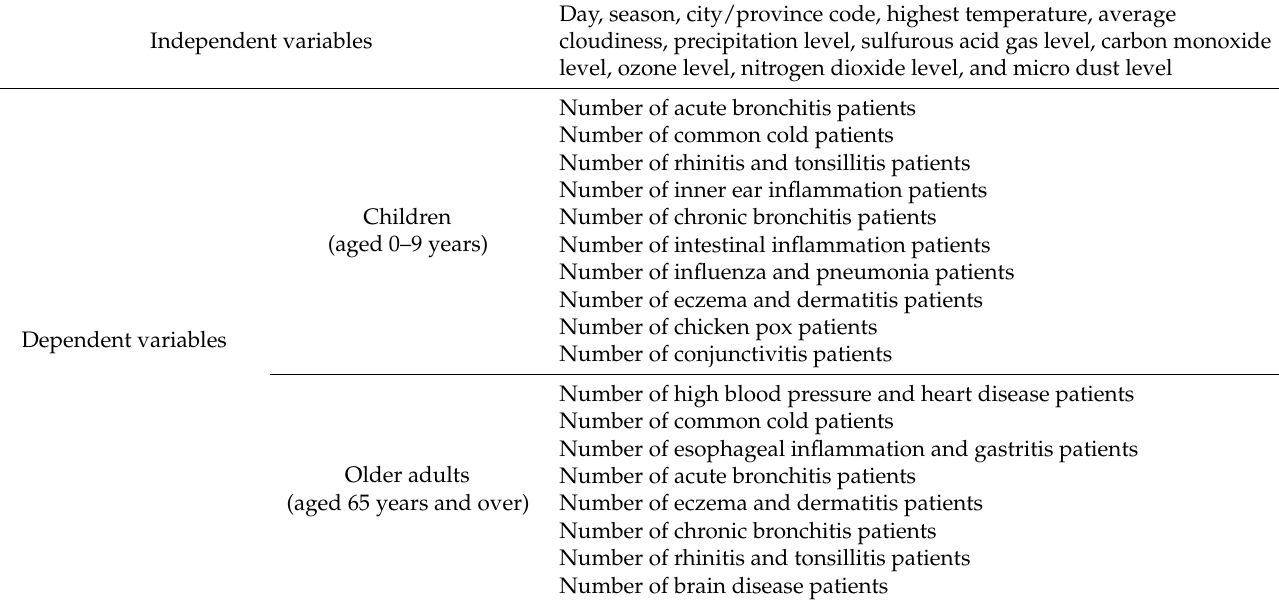
Table 2. Independent and dependent variables for children and older adults.